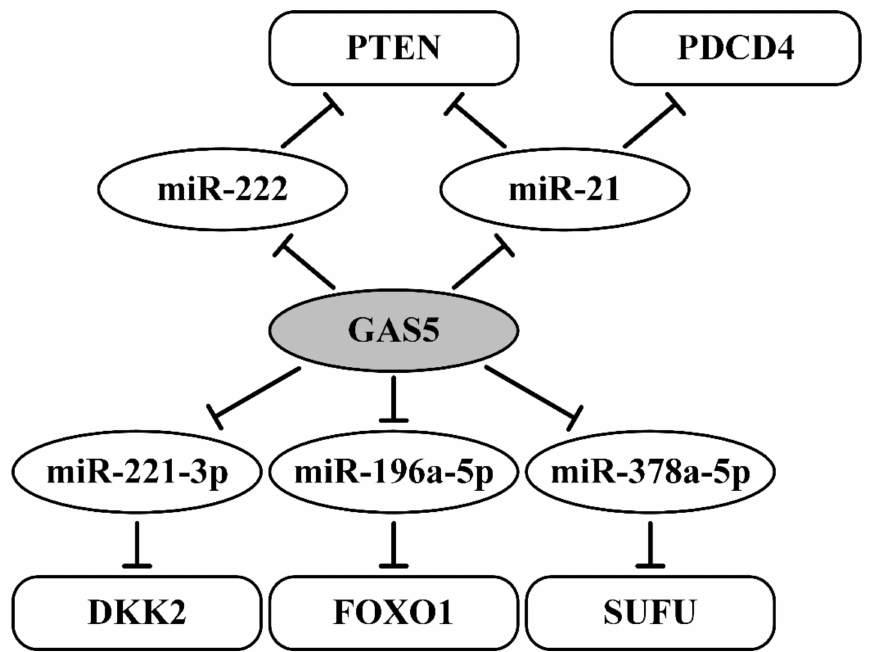
Figure 2. Regulating axes of lncRNA GAS5 in breast cancer. Blunt arrows indicate inhibitory effects. The following references were used: